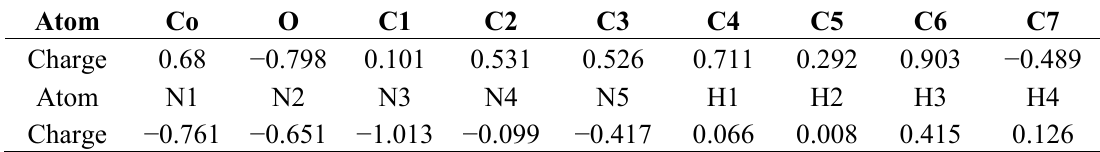
Table 3. Atomic partial charges for